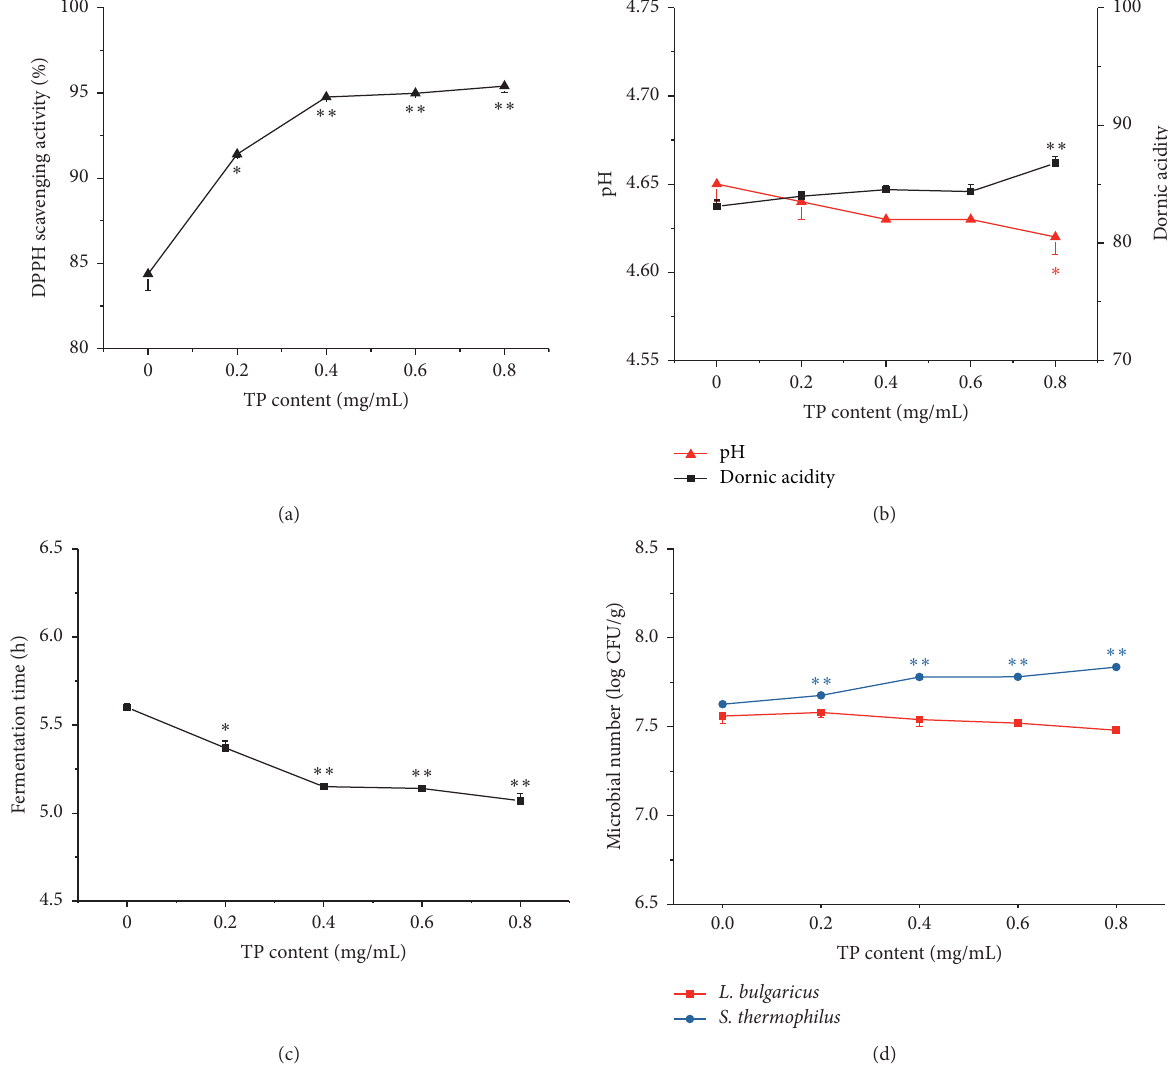
FSE:Flos Sophorae extract;TP: Tremella fuciformis polysaccharides;Con:theyogurt withoutFSEor TP;basedon2.4% FSE,thedifferent concentrationsofTP (0, 0.2, 0.4, 0.6, and 0.8mg/mL milk) were added to produce FSE2.4, FSE-TP0.2, FSE-TP0.4, FSE-TP0.6, and FSE-TP0.8 yogurts; tan δ � G ″ / G ′ . In each column, the values with different letters indicated significant differences among groups ( p < 0 . 05).